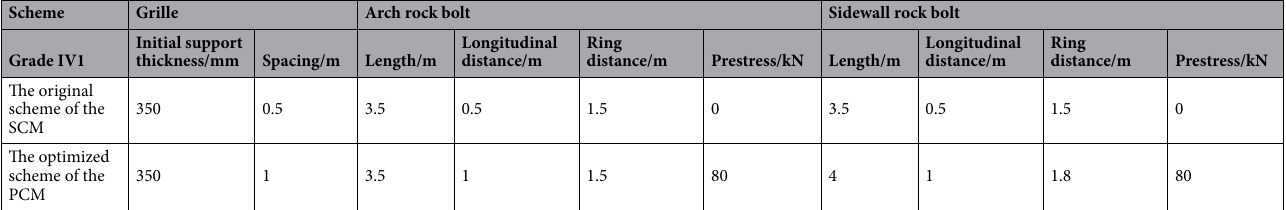
Table 8. Parameters used by the two construction methods.